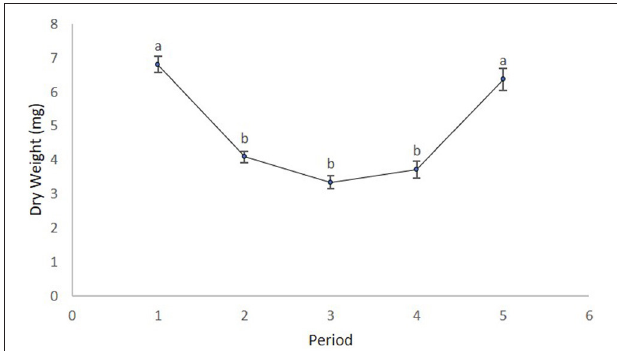
FIGURE 3 | The mean ± dry weight (mg) of individual pollen pellets collected by bees over the five time periods. Time periods with different letters are statistically different from one another as indicated by multiple means